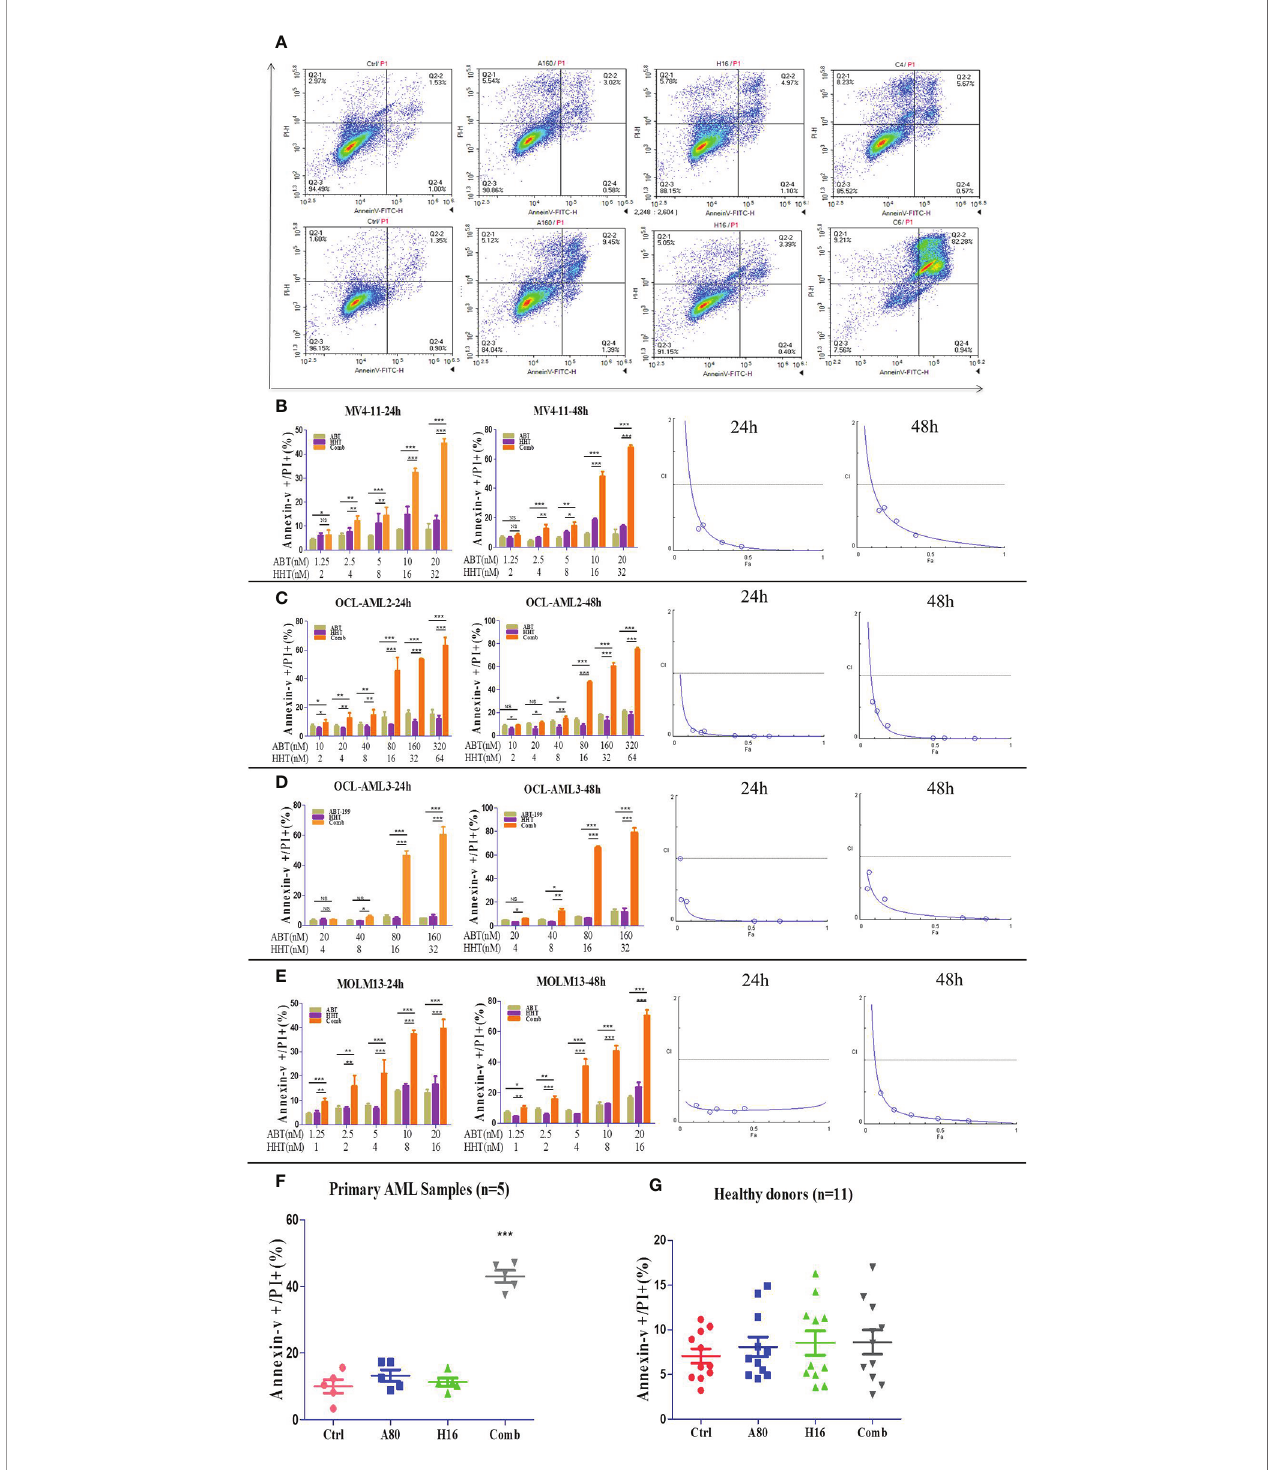
FIGURE 2 | The percentage of apoptotic cells was examined with a NovoCyte fl ow cytometer. ABT-199 combined with HHT resulted in signi fi cant increases in the apoptosis rate in AML cell lines (A) . The same results were observed in primary leukemia samples (B – F) . The combination regimen exhibited minimal toxicity to normal peripheral blood mononuclear cells obtained from healthy donors (G) (*P < 0.05, **P < 0.01, and ***P < 0.001; NS, not signi fi